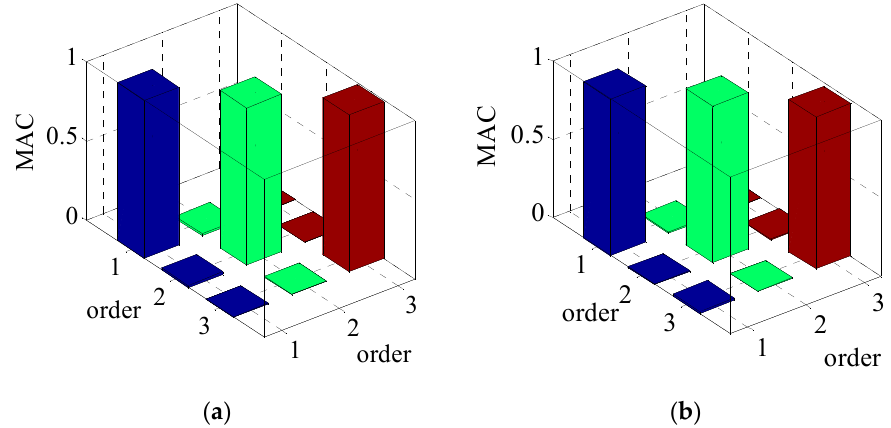
Figure 19. MAC histograms of the first three mode shapes under 10 min wind speeds of 2.96 m/s and 20.02 m/s. ( a ) along x -axis; ( b ) along y -axis. Table 5. MAC values of measured U 10min relative to 2.96 m/s in the first three mode shapes with the same order.